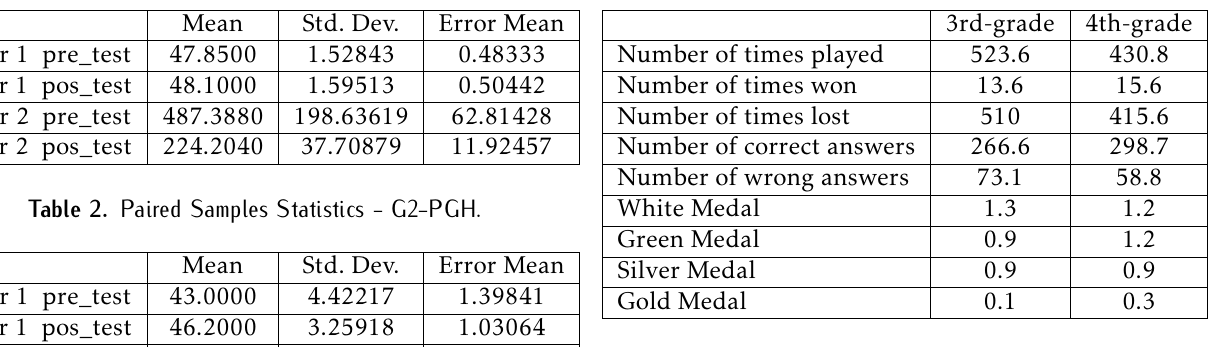
Table 5. Mean of the data recorded for groups G1 and